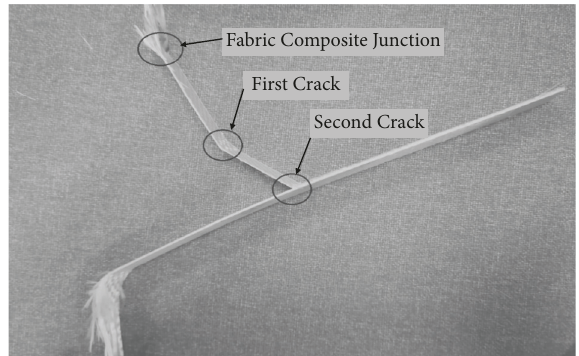
Figure 8: Actual sample after delamination test showing first crack and second crack.